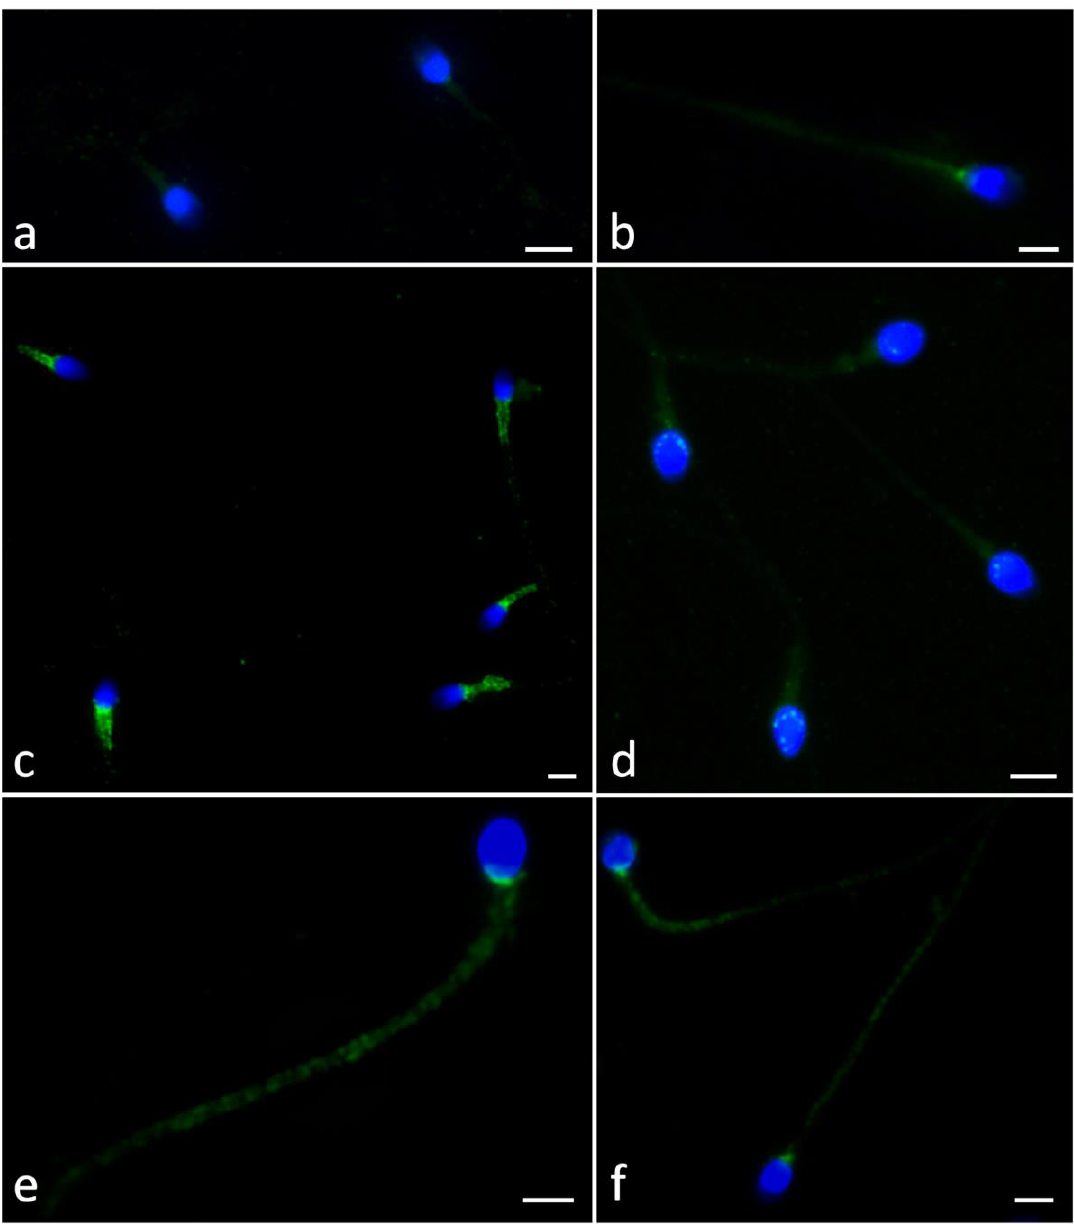
Figure 2. UV micrographs of swim-up selected sperm treated with anti-ryanodine antibody. The percentage of localization differed in control samples or those incubated with F 4 -NeuroPs for 2 or 4 h. In the controls, a high percentage of sperm showed diffuse and fair labeling ( a ) or a spot localized in the centriolar region ( b ). Sperm incubated for 2 h with F 4 -NeuroPs showed strong signals in the midpiece and postacrosomal sheath ( c , d ). After 4 h F 4 -NeuroP incubation, the labeling appeared dotted along the total tail ( e , f ). Nuclei (blue) were stained with DAPI. Figure 2 without DAPI was included in Supplementary material. Bars: 6 μM.